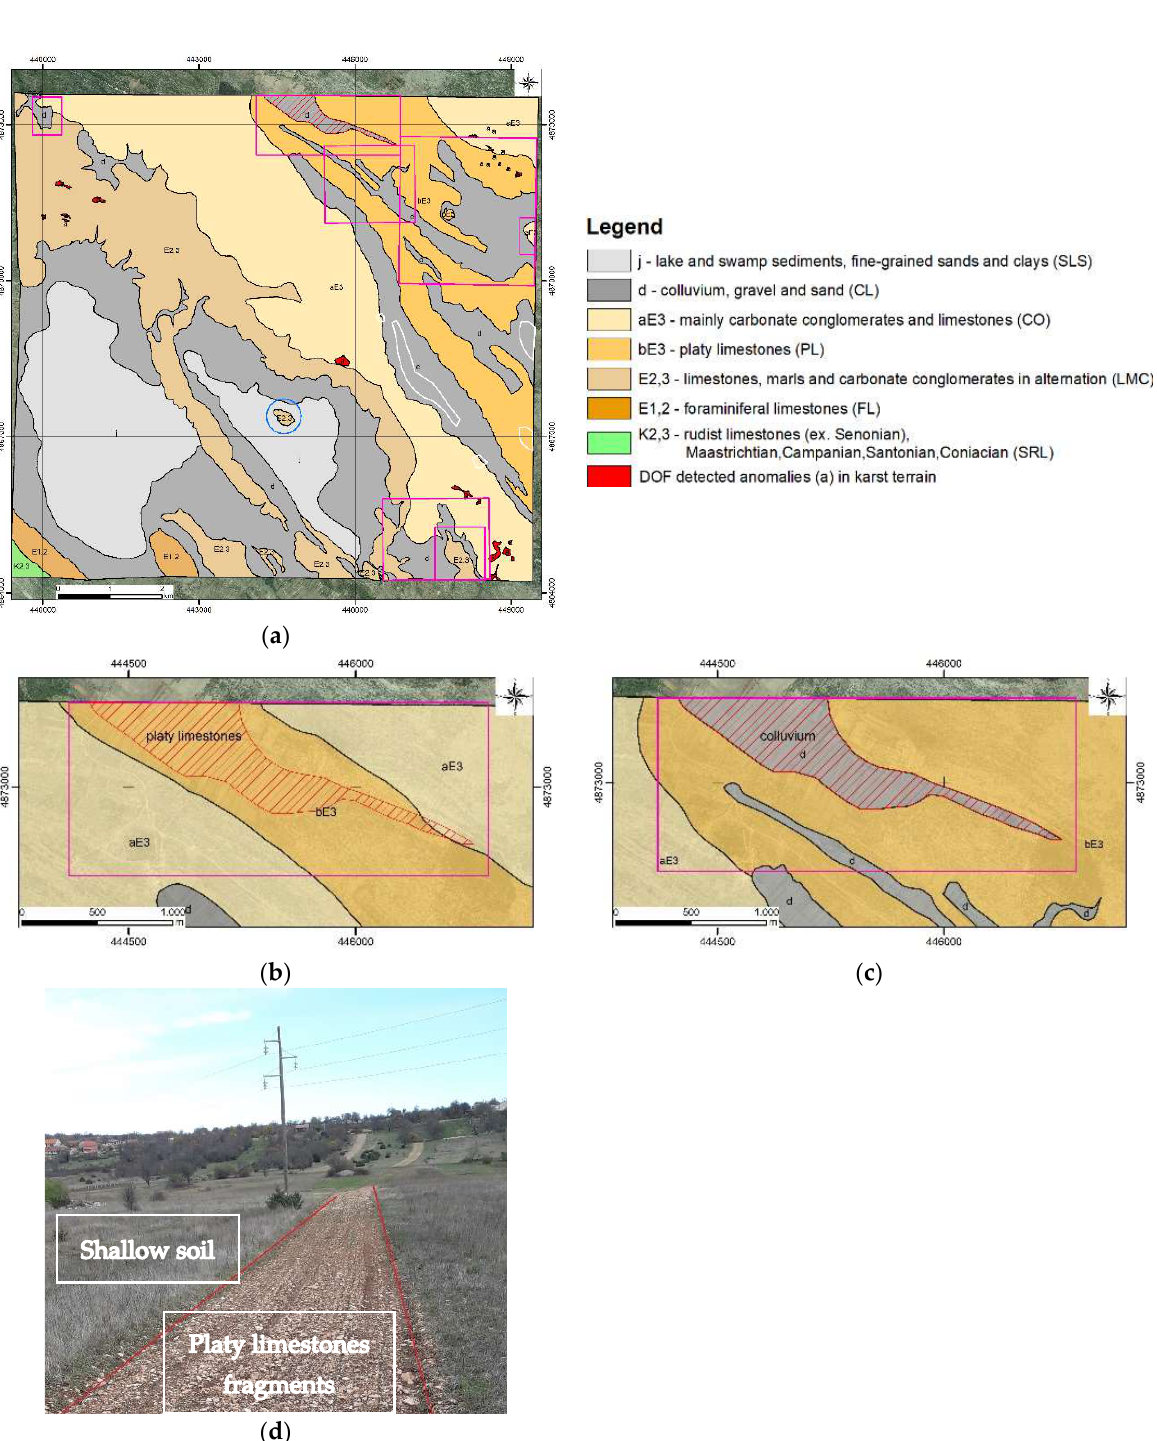
Figure 9. ( a ) K-means and DOF-derived geological map of Bribirske Mostine with all LODs; ( b ) clip from field geological map of the OGK SFRJ, sheet Bribirske Mostine (Figure 1c); ( c ) clip from K- means and DOF-derived map (Figure 9a); ( d ) ground truth data—shallow soil with platy limestone fragments is shown.